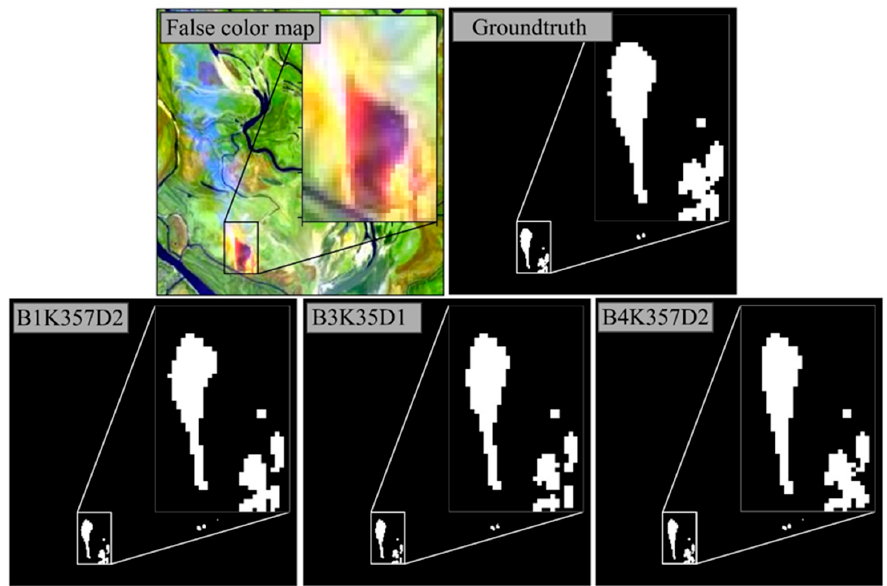
Figure 8. Comparison between the three best models for AFD by MultiScale-Net.